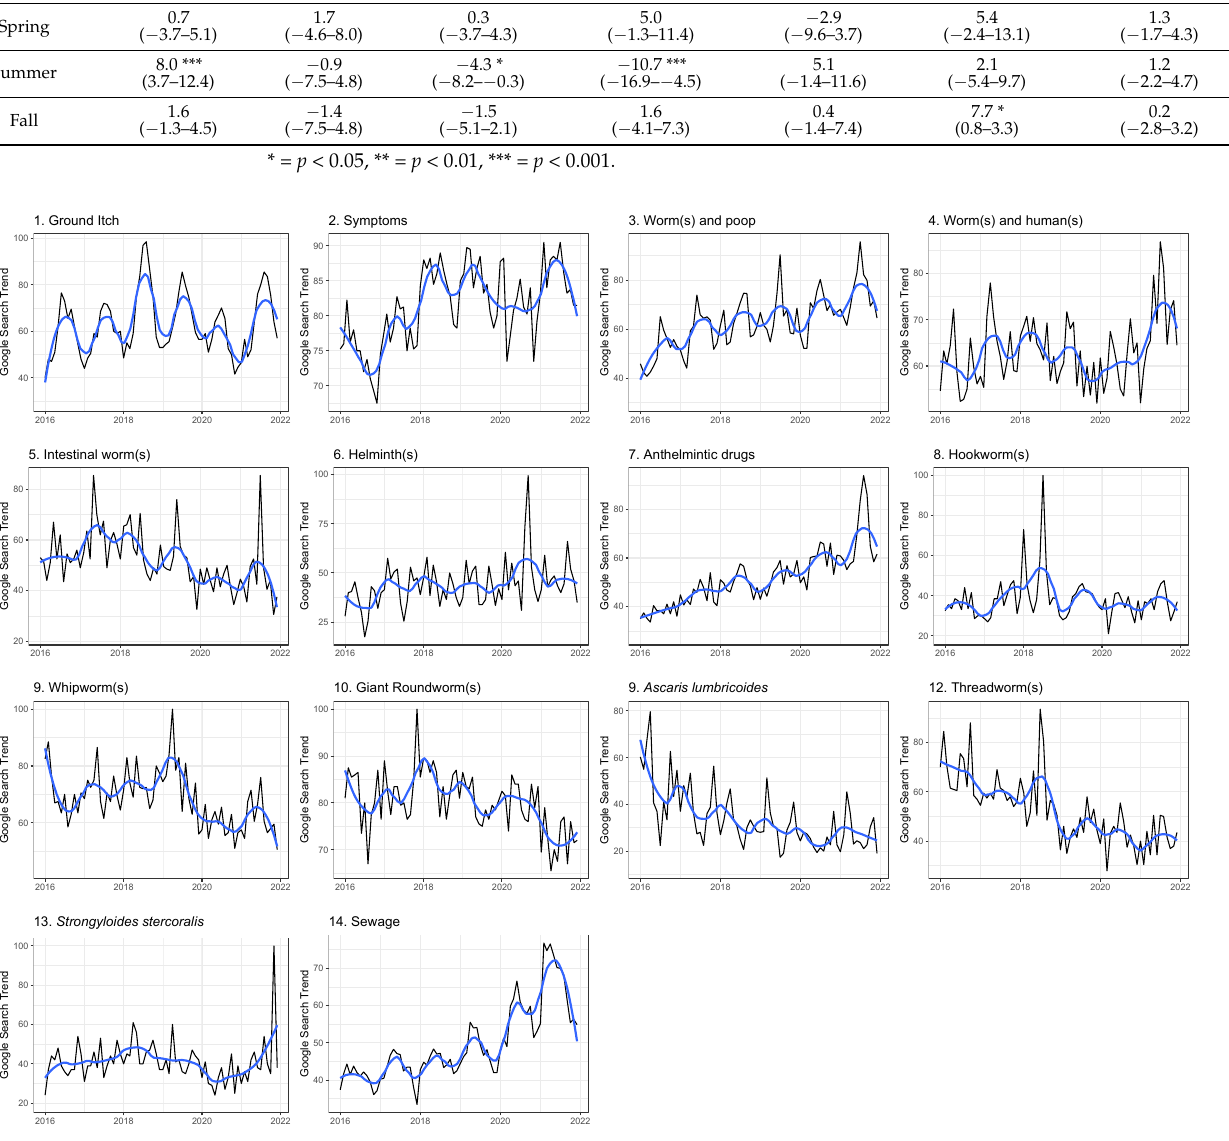
Figure 2. Trends in monthly search engine traffic for fourteen categories of searches related to soil- transmitted helminths from 2016 to 2021. The black line shows the actual measure of search engine traffic. The blue line shows a Loess smoothing with a span limited to 0.25. (1–13) Thirteen categories of search terms related to soil-transmitted helminths plotted by state using the mean of data from 2016 to 2021. (14) Category of search terms related to sanitation infrastructure deficiencies plotted by state using the mean of data from 2016 to 2021. The number for each map corresponds to Table 1, categories 1–14, showing the exact search terms